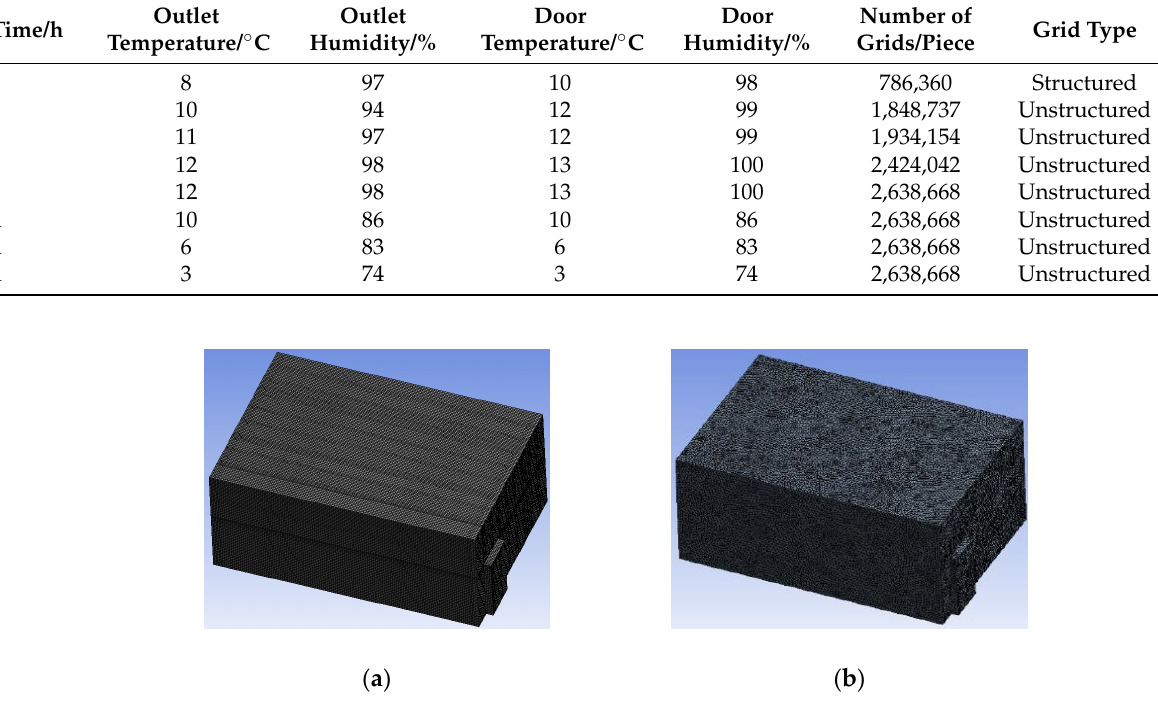
Table 3. Fluid simulation of wind speed, temperature, and humidity in a chiller. Time/h